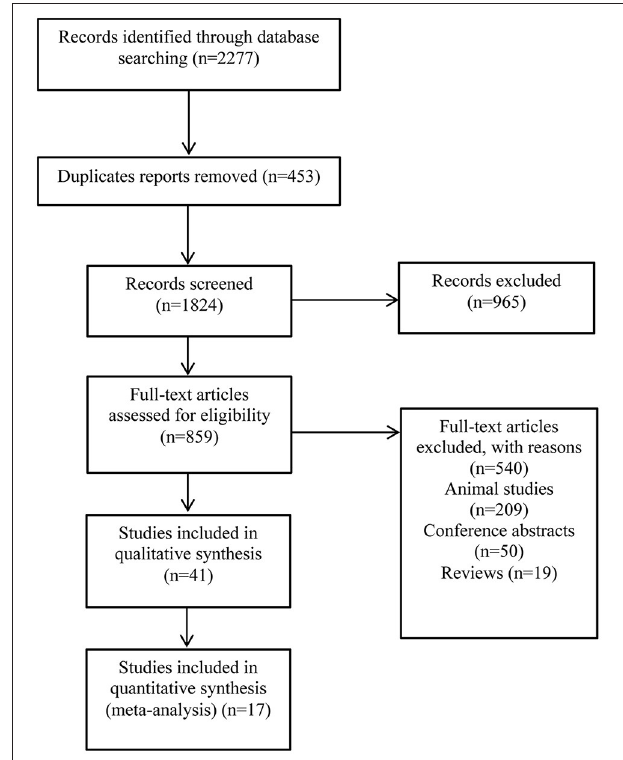
FIGURE 1 | Selection process and criteria for inclusion in this study.